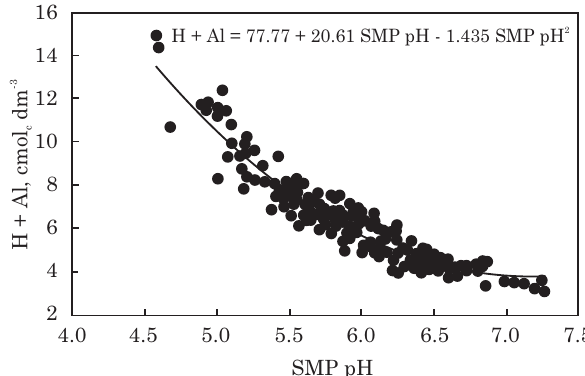
Figure 1. Relationship between the H + Al concentrations determined by the method of calcium acetate and SMP pH in representative soil samples of the State of Pará * Significant by regression analysis (p<0.05).